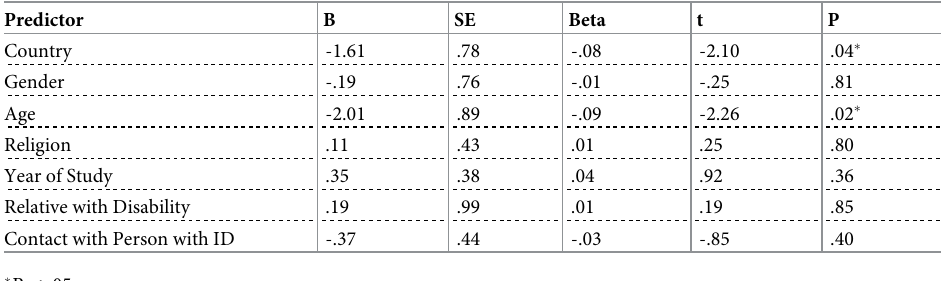
Table 4. Summary of demographics regressed on attitude. Predictor